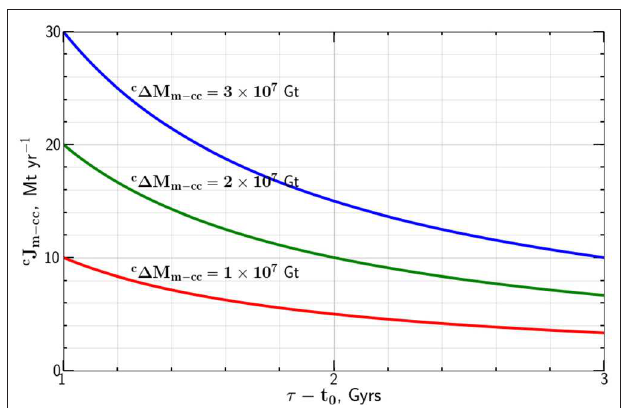
FIGURE 3 | Dependence of the present mass flux of carbon from the mantle to the continental crust c J ( m − cc ) p , required to generate c 1 M m − cc mass of carbon in the continental crust, in a time t p − t 0 , on this time difference.